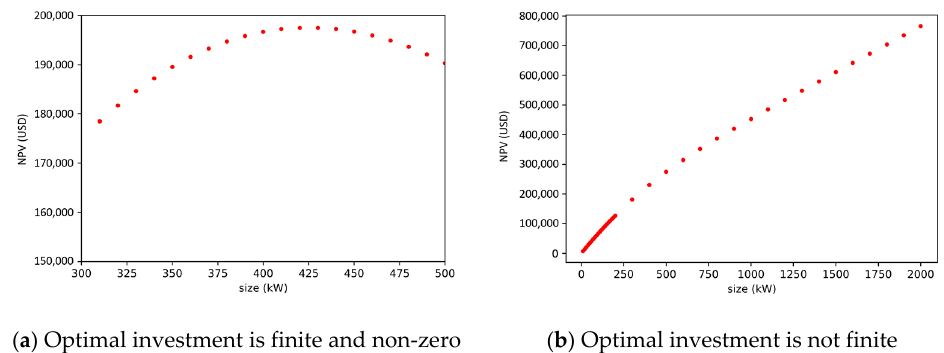
Figure A5. Illustration of possible relationships between the size of a rooftop PV installation (optimization variable) and the NPV (objective function expressed in USD). mization variable) and the NPV (objective function expressed in